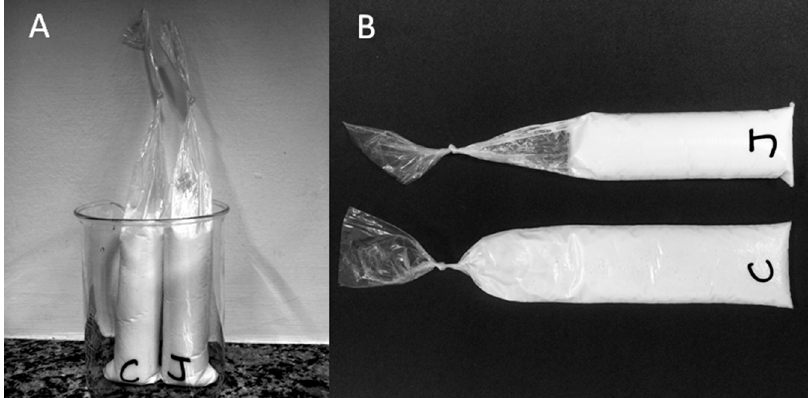
Figure 1. Milk clot procedure done in candy plastic bags. ( A ) After preparation of the samples, they need to be placed inside a beaker to maintain the solutions in the same level. ( B ) After the reaction, the bags were placed on the bench for manipulation by the blind student. The marks “C” and “J” indicate the bags with the addition of water (control) and pineapple juice (experimental condition), respectively. It is important to note the diagonal cut in the opening of the bag where the enzyme was added (J bag) to help the blind students to distinguish one sample from the other. In the control sample the milk remained liquid, and in the sample containing pineapple juice, the milk clot. The student can feel the difference by touching the bags.